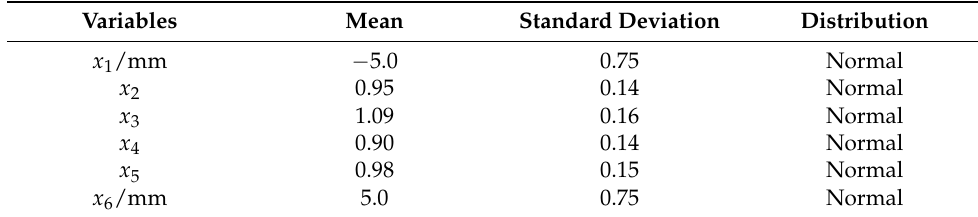
Table 5. Design variable probabilistic distributions.